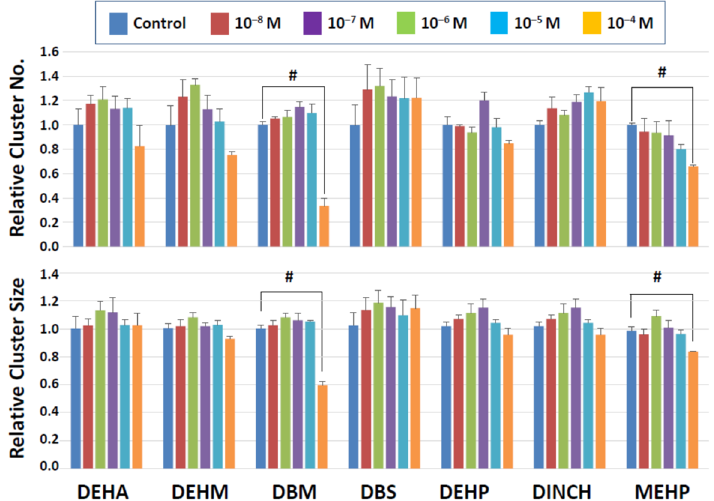
Figure 2. Cluster numbers and sizes after 2-day exposure to commercial plasticizers. The data are normalized to the results of control (DMSO) treatment. Hash signs (#) indicate significant differences ( p < 0.05).